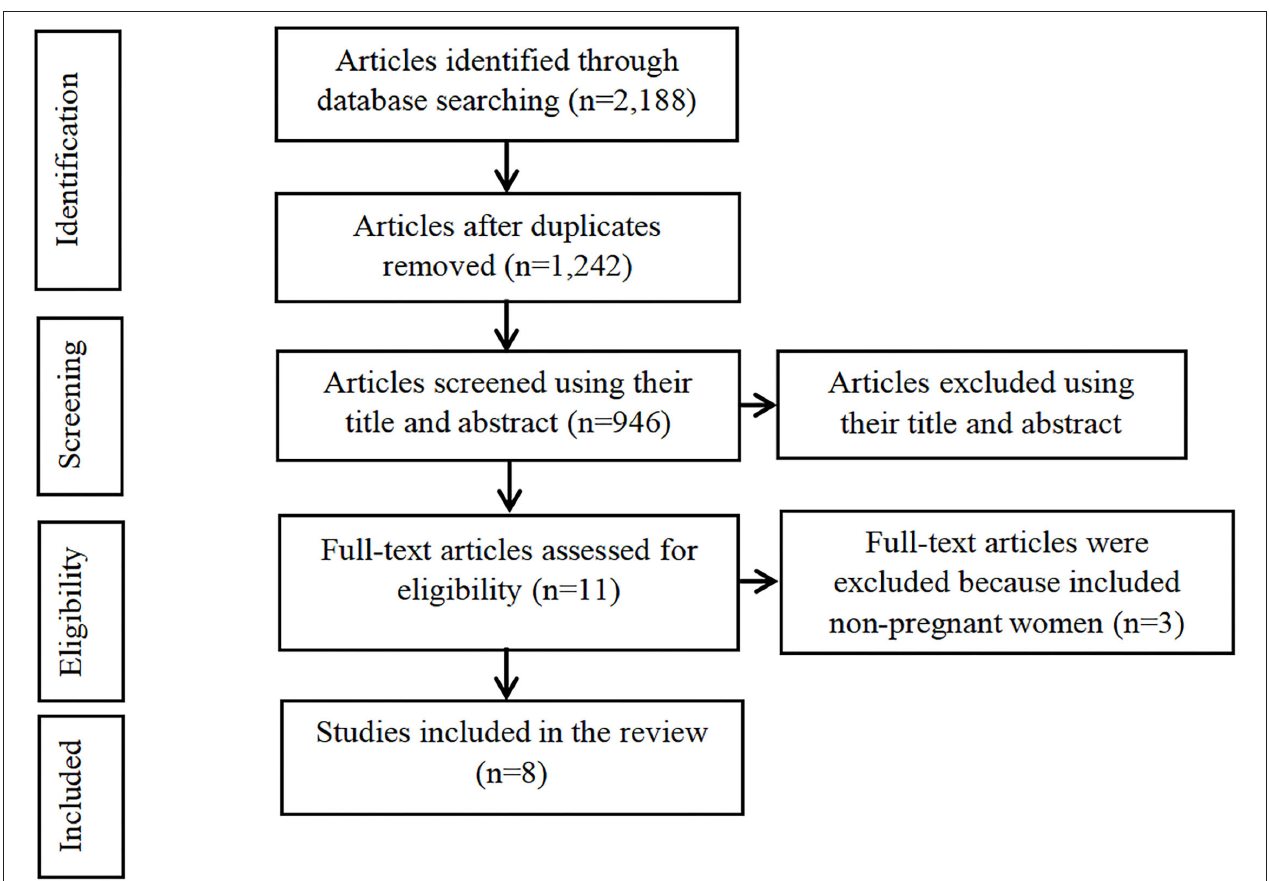
FIGURE 1 | Flow diagram of the studies included in the systematic